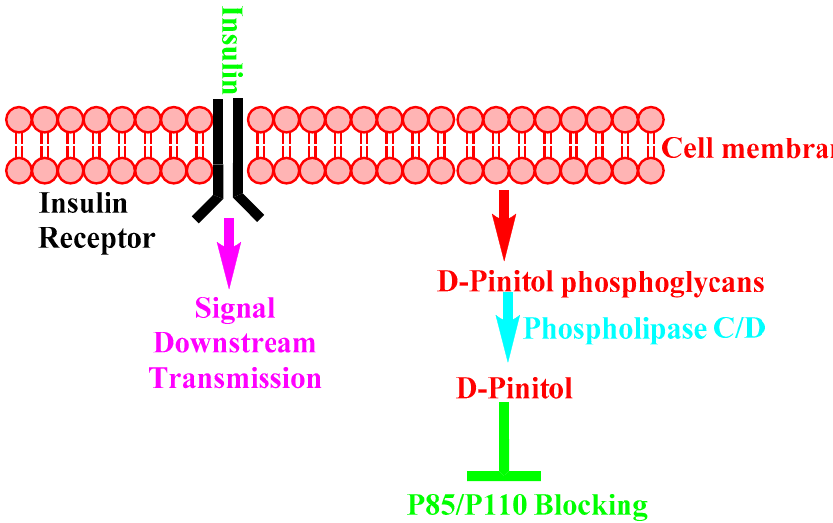
Figure 8. Insulin-sensitizing mechanism of D-Pinitol.